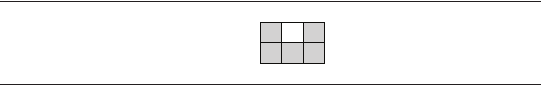
FIGURE 1: Example of a fraction as part of a